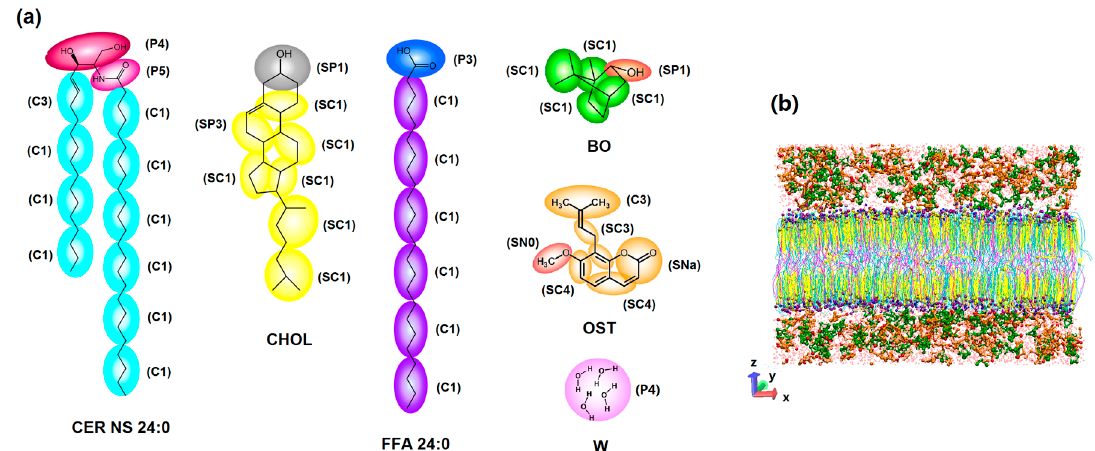
Figure 12. CG models for simulation systems: ( a ) the chemical structure and CG mapping for Ceramide- N -sphingosine (CER NS), cholesterol (CHOL), free fatty acids (FFA), borneol (BO), osthole (OST) and solvent water W based on Martini force field; and ( b ) a side view of a typical simulation system (membrane with 5% BO and 10% OST in water).